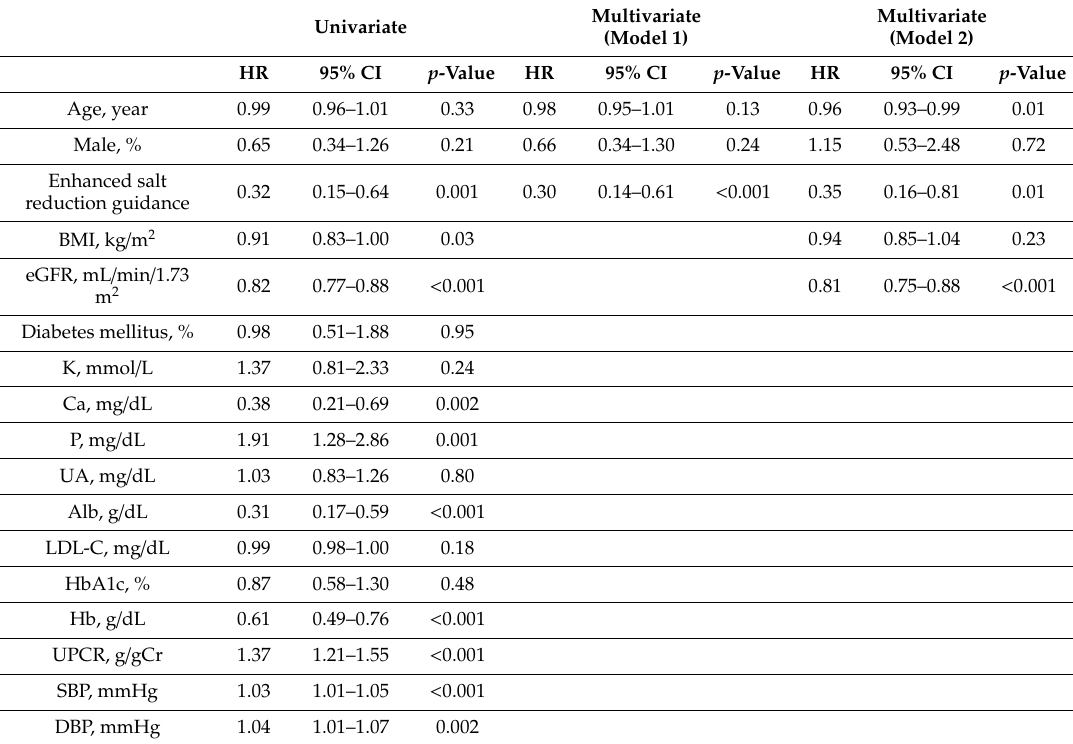
Table 4. Univariate and multivariate logistic regression analyses of the dialysis induction